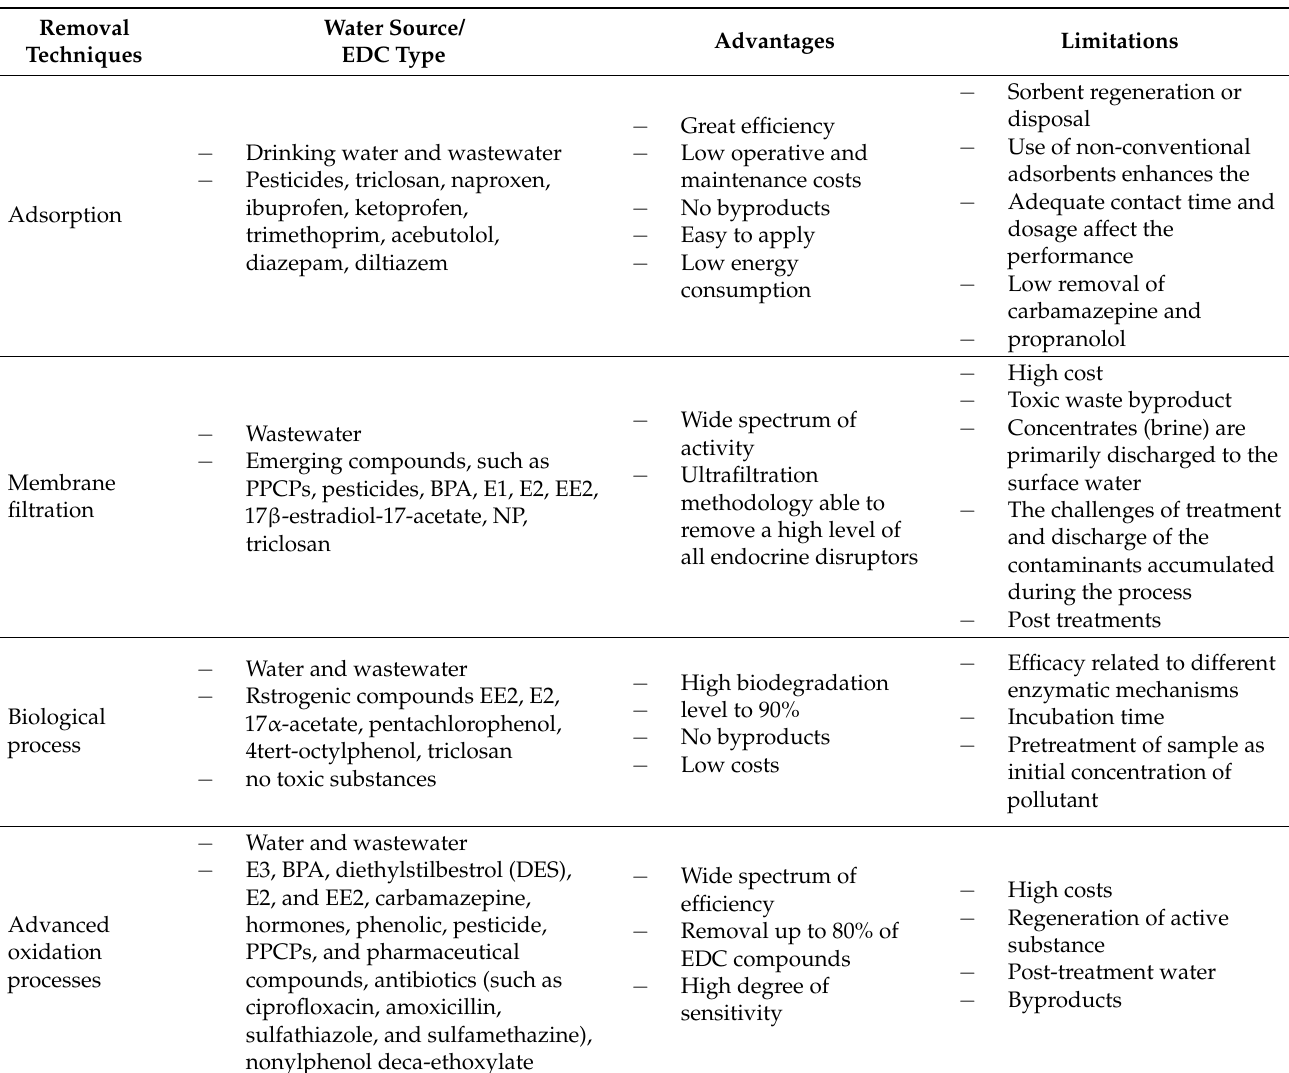
Table 3. Comparison of removal treatment strategies for endocrine-disrupting chemicals in water and wastewater systems. Removal